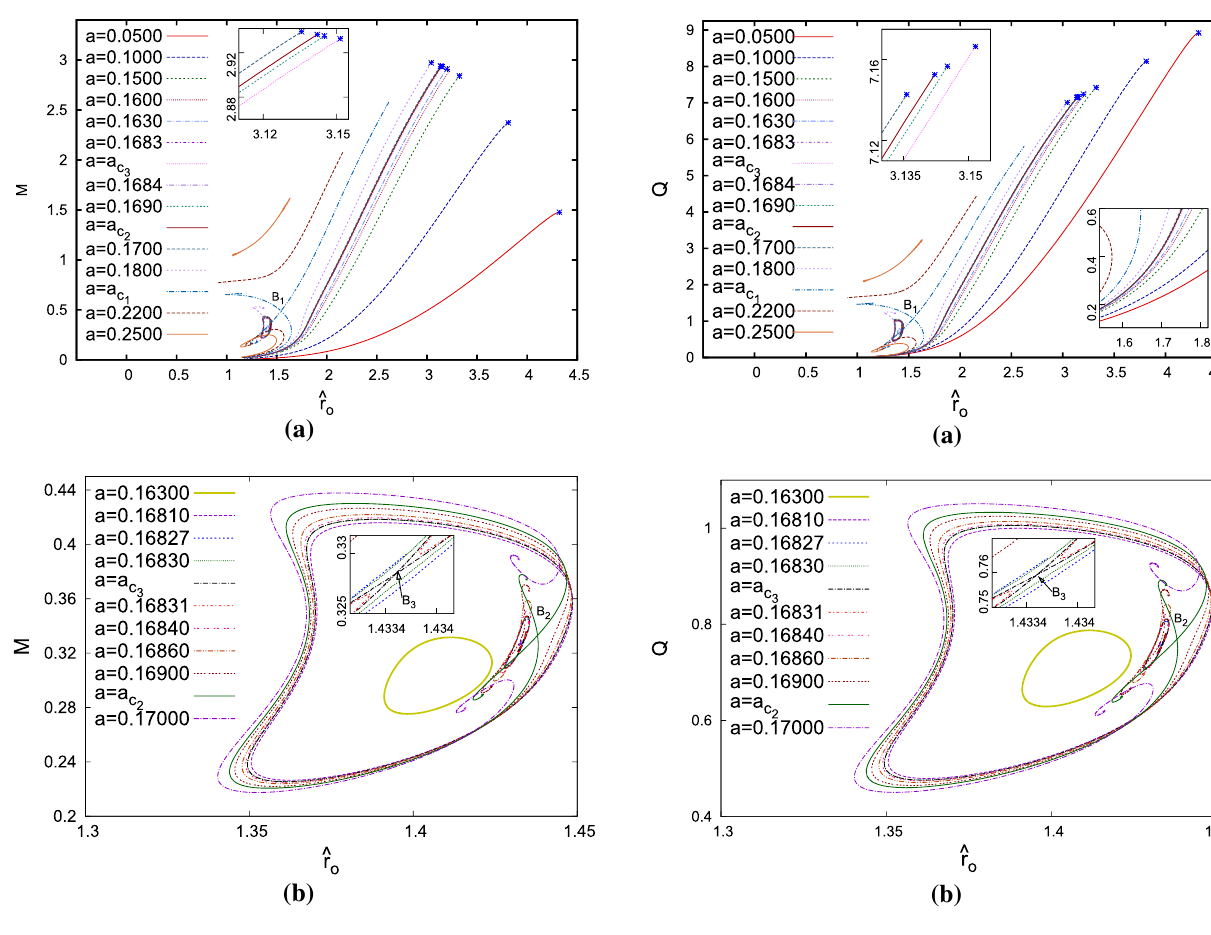
Fig. 6 a The Charge Q versus the radius of the star ˆ r o for the same sequence of values of the parameter a . The asterisks represent the tran- sitionpointsfromthebosonstarstobosonshells,andtheinsetsmagnify parts of the diagram. b Zooms into the region of the bifurcations, with the inset giving a magnified view of the bifurcation